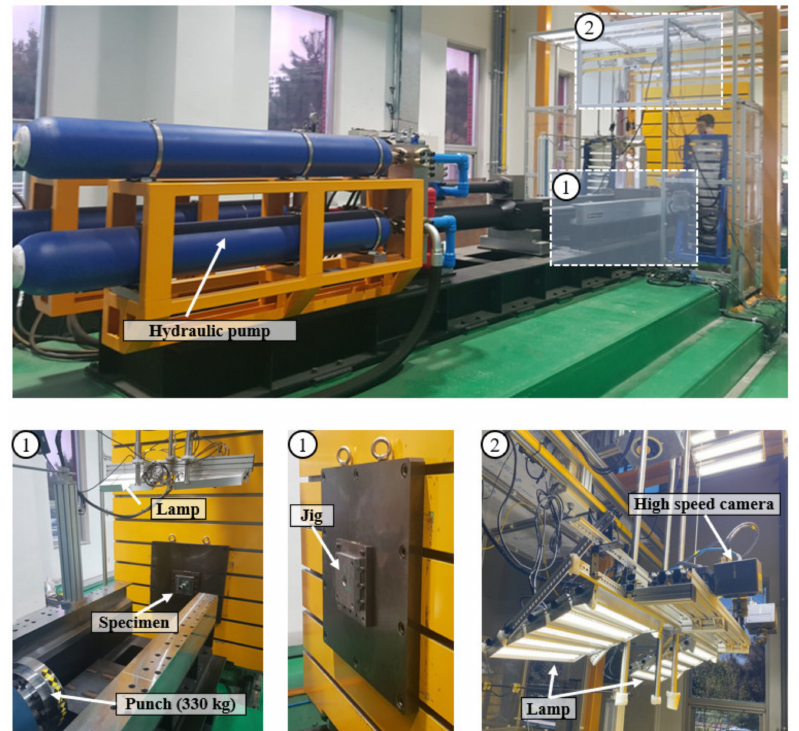
Figure 4. Experimental set-up for dynamic crash